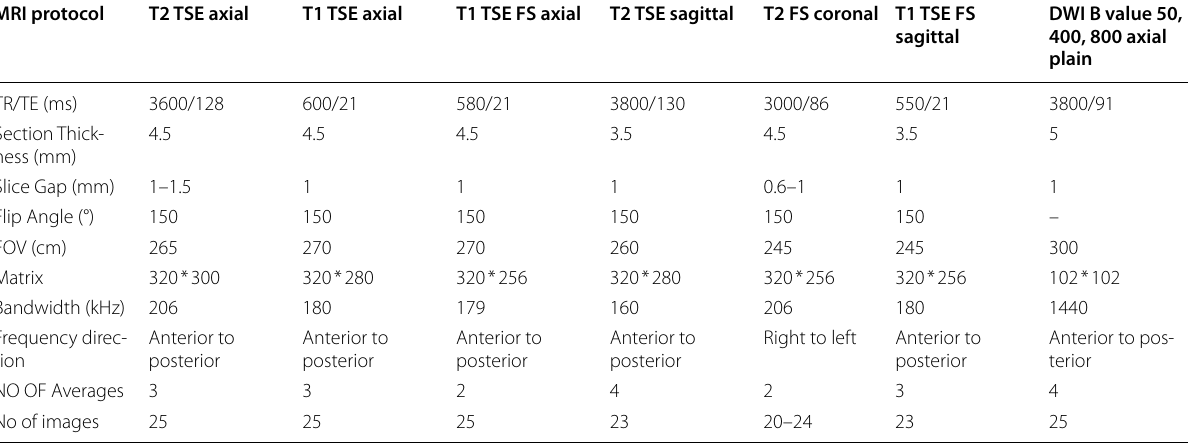
Table 1 Imaging sequences that were used and their characteristics MRI